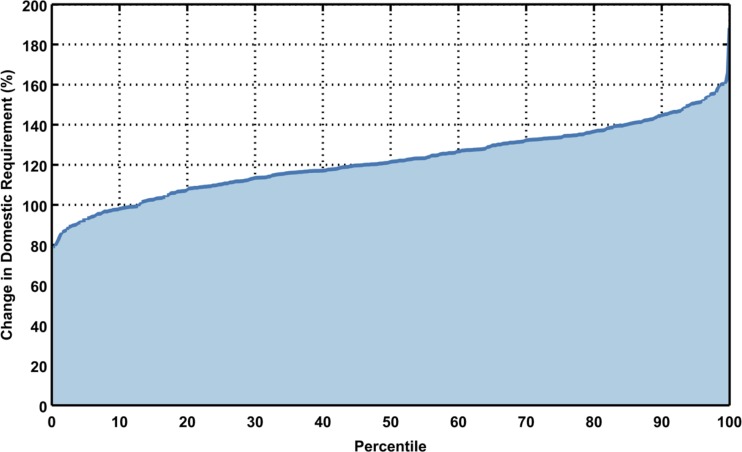
As in Fig 13, but for percent change in domestic requirement for the region for all scenarios.Each point in the line represents one of 400 growth scenarios. Percent change for each ASR in each scenario is weighted by population.